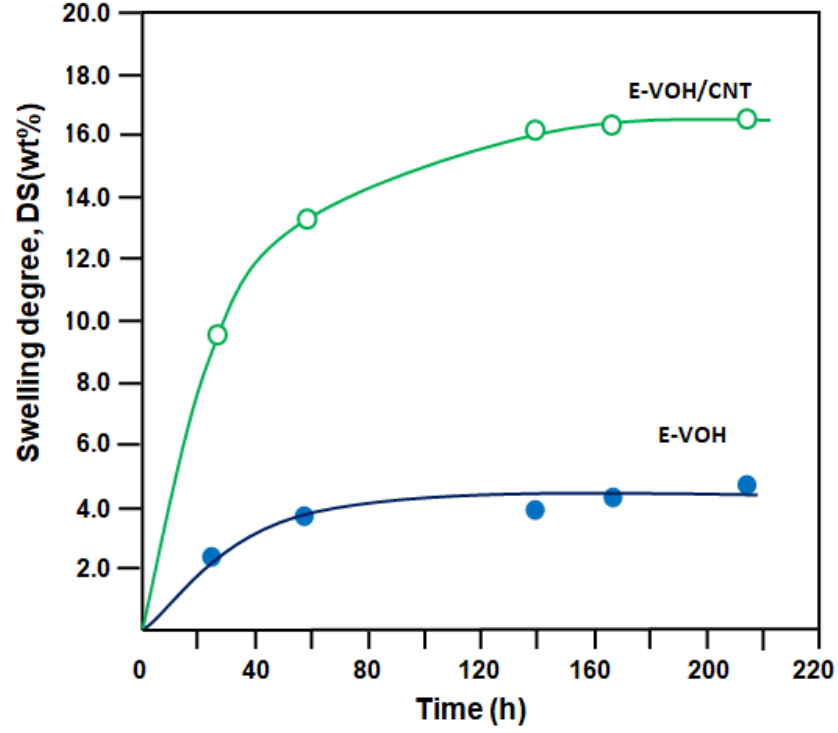
Figure 6. Comparison of the swelling degrees between E-VOH and E-VOH/CNT membranes in benzene/cyclohexane mixtures with equal compositions versus time measured at 25 °C. Table 2. Comparison of the swelling degrees between E-VAL and E-VAL/CNT membranes in benzene/cyclohexane mixtures with different compositions.